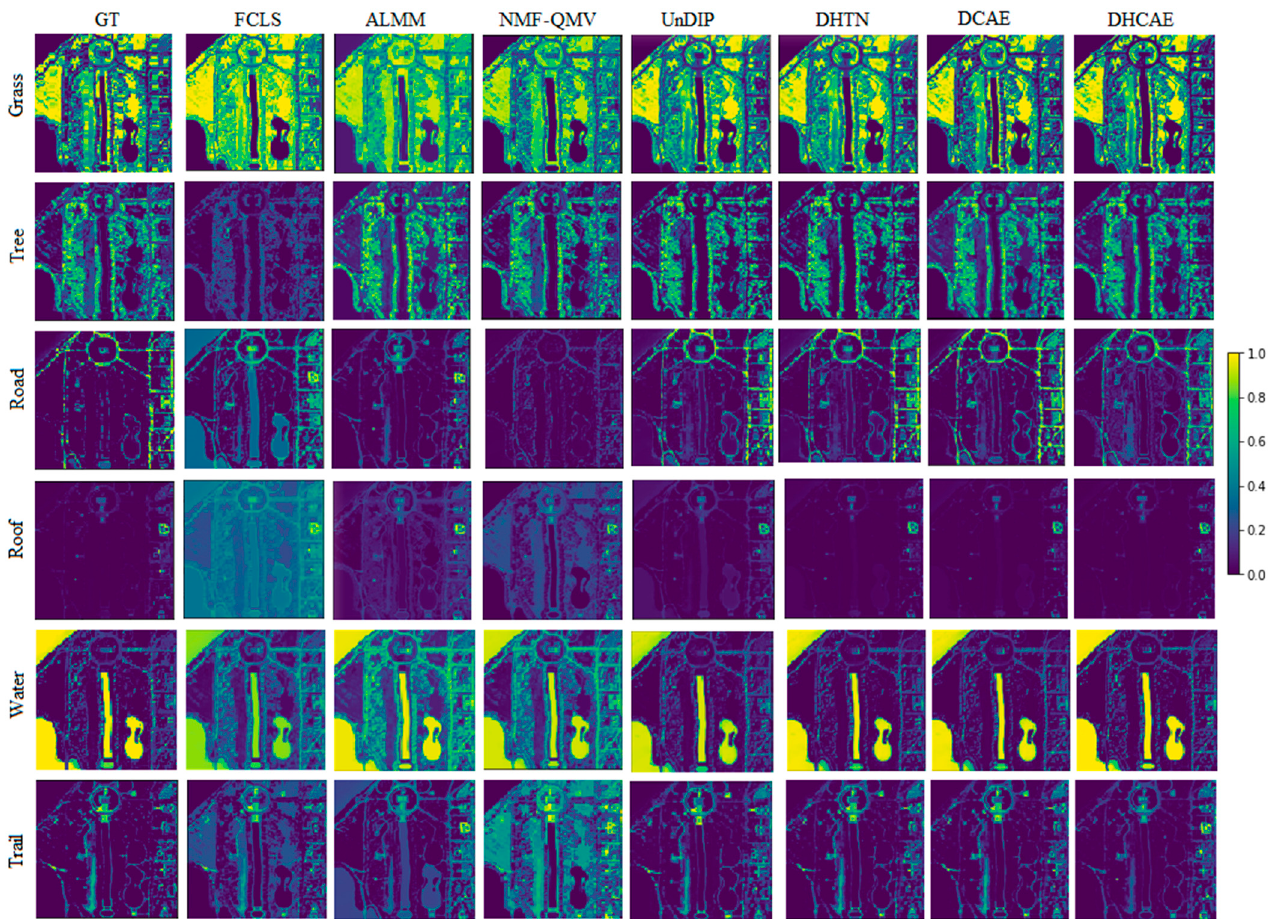
Figure 15. Washington DC Mall data. Ground truth (GT) map in the first column and extracted abundance maps of different spectral unmixing methods.